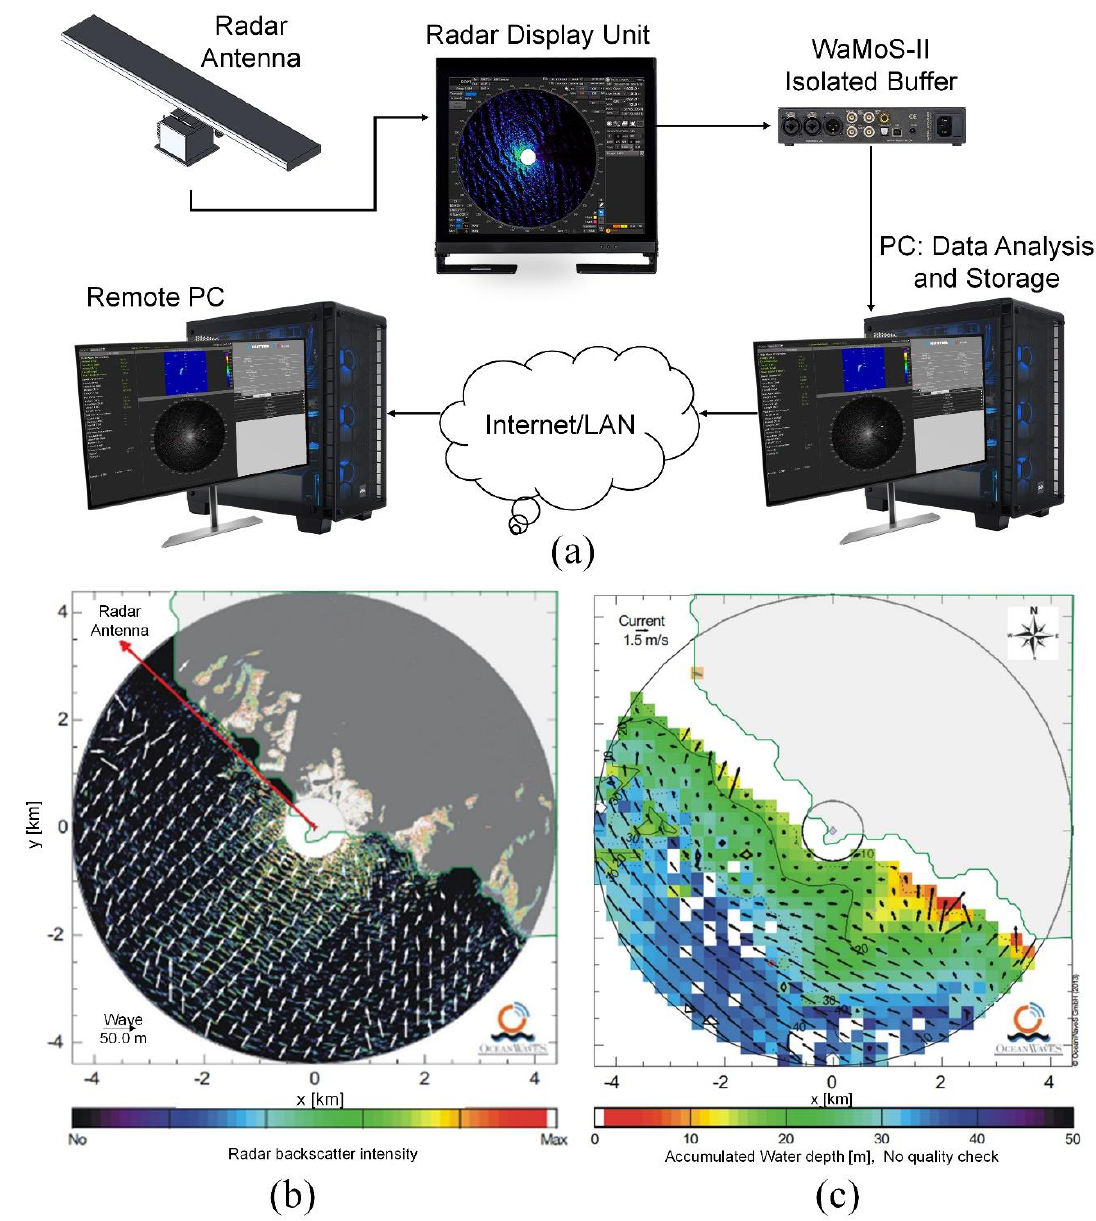
Figure 6. ( a ) Outline of the WaMoS II setting up, ( b ) sample of a WaMoS II X-band radar backscatter image, and ( c ) its bathymetry and current field at Tongue Point, Cape Terawhiti, New Zealand. The white arrows in ( b ) and black arrows in ( c ) show the peak wave direction of the incoming waves and the current vectors, respectively. The figure is directly adopted from Ref. [73,121].